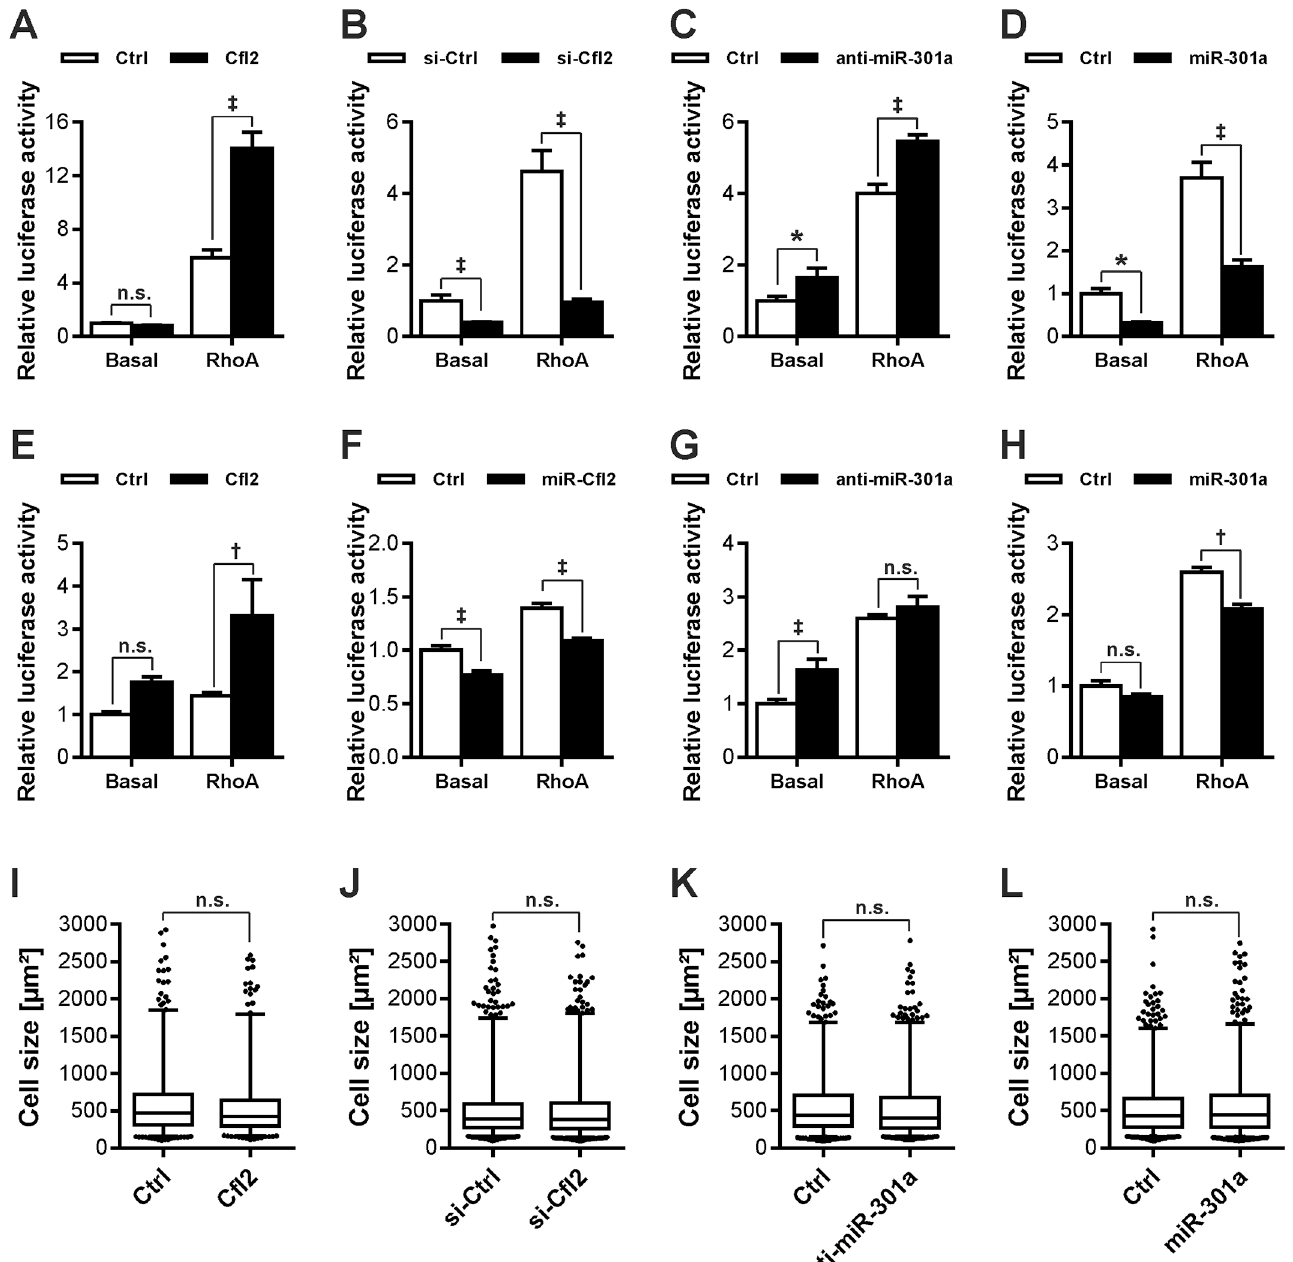
Fig 5. miR-301aand Cfl2 oppositely regulates Rho-mediated SRF signaling. Cfl2 or miR-301awere either overexpressed or knocked-down usingrespectivevectors, mimic, or inhibitortransfection in C2C12cells togetherwith a luciferaseconstruct carryingSRF-RE driven firefly luciferase. Overexpression of Cfl2 additivelyincreasedthe luciferaseactivationby either constitutively RhoA ( A ),whereas, its siRNA led to inhibition of luciferase activation,basal, as well as in presenceof RhoA ( B ).Knockdown of miR-301aalsoincreasedthe luciferaseactivation( C ),and the overexpressionof miR-301amimic significantly bluntedthe luciferaseactivity ( D ).For SRF-gene reporter assays in NRVCM, Cfl2 was overexpressed usingadenovirus encoding rat Cfl2, whereas,its knockdownwas achievedusingadenovirusencoding synthetic microRNAspecifically targetingCfl2. Expressionof miR-301awas modulatedin NRVCMsame as in C2C12cells. Like in C2C12cells, Overexpression of Cfl2 in NRVCMalso exhibitedpositiveeffect on the activation of luciferaseactivity ( E ); knockdown of Cfl2 on the other handsignificantly inhibitedthe activationof SRF-RE driven luciferaseactivity ( F ). Consistently, alteredexpression of miR-301aby treating NRVCMwith miR-301a inhibitor( G )or mimic ( H )oppositelyaffected the luciferaseactivation. Increased expression of Cfl2 in NRVCMdid not alter cell surface area ( I ). Knockdownof miR-301aalso led to no effect on cell size ( J ).Similarly, siRNA mediatedknockdown of Cfl2 ( K )or overexpression of miR-301atoo did not alter cell surface area ( L ). N > 500for cell size measurements, and N = 6 luciferaseassays. All experiments havebeenrepeatedat least twice. The statistical analysiswas carriedout usingtwo-tailedstudent’s t-test . * : p < 0.05,‡: p < 0.001,n.s.: non-significant. https://doi.org/10.1371/journal.pone.0183901.g005 PLOS ONE | https://doi.org/10.1371/journal.pone.0183901 September 8,